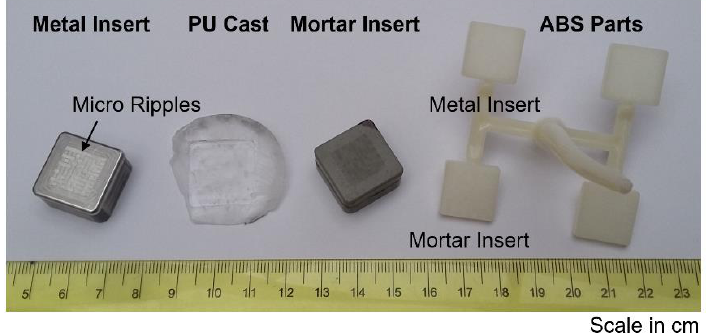
Figure 6. Products of mortar insert rapid prototyping process chain. The polyurethane (PU) replica is transparent. The acrylonitrile butadiene styrene (ABS) plastic component made with both inserts and by micro injection moulding is also shown.